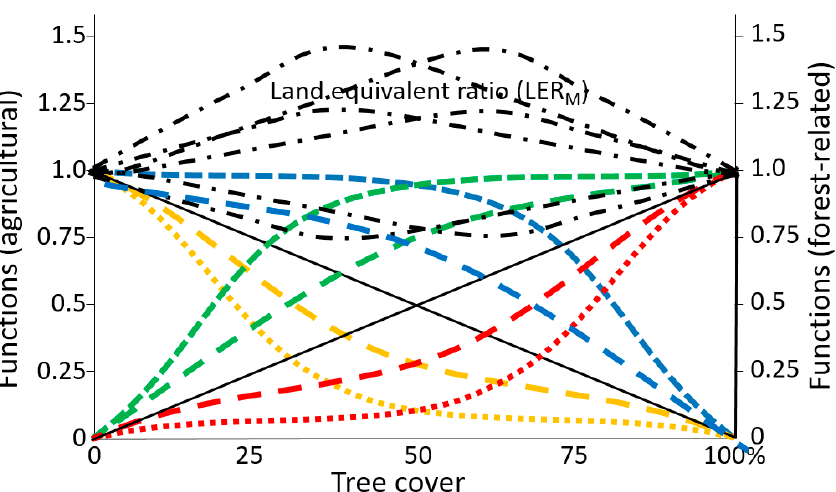
Figure 8. Schematic relationships of various land functions, either agricultural or forest-related, in relation to the percentage tree cover on a unit of land [67]; depending on the weights assigned to the various functions, the LER sum across functions can be convex, with an intermediate tree-density optimum, or concave, with an advantage for segregating.